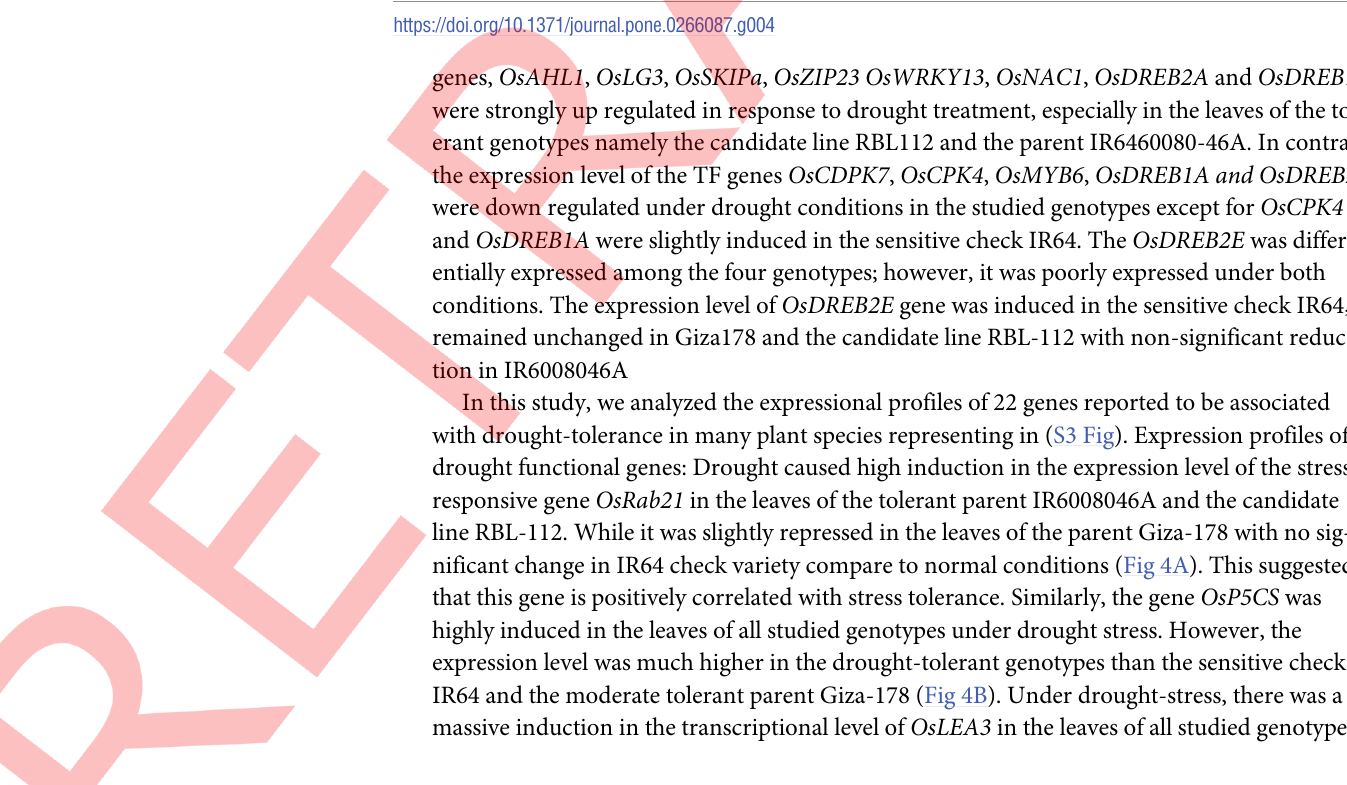
Fig 4. The expression level of OsRab21 (A), OsP5CS (B), OsLEA3 and OsHSP101 (D), under normal and drought-stress conditions. Data are represent as means ± SEM, (n =